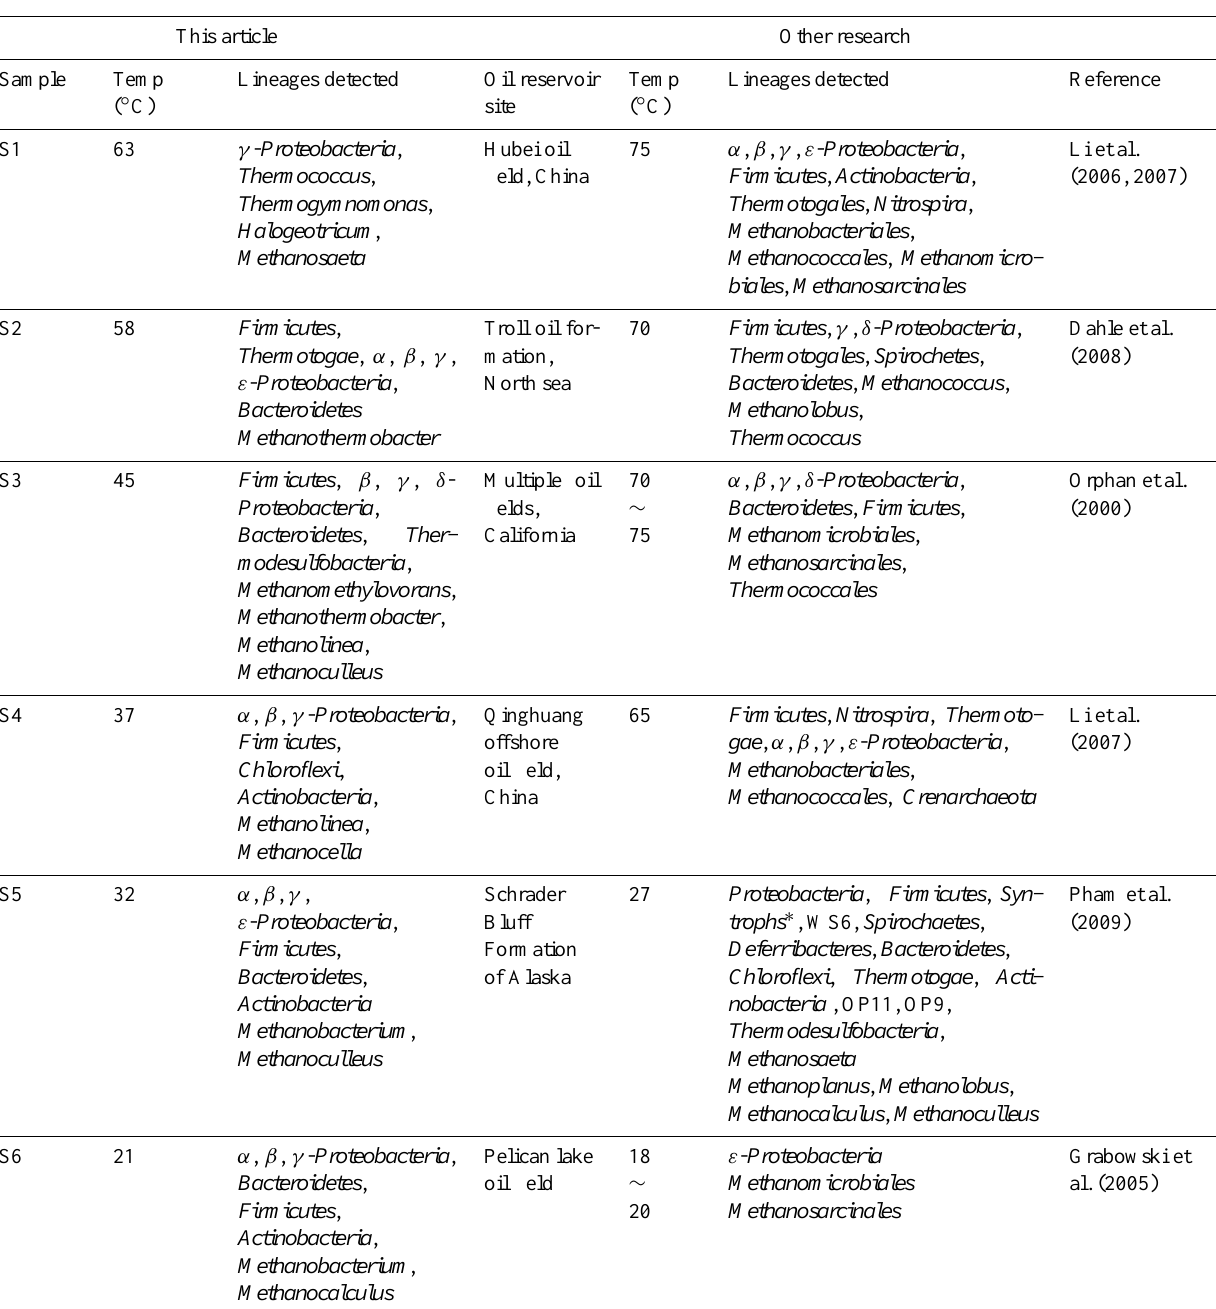
Table 2. 16S rRNA gene sequencing surveys conducted in different temperature petroleum